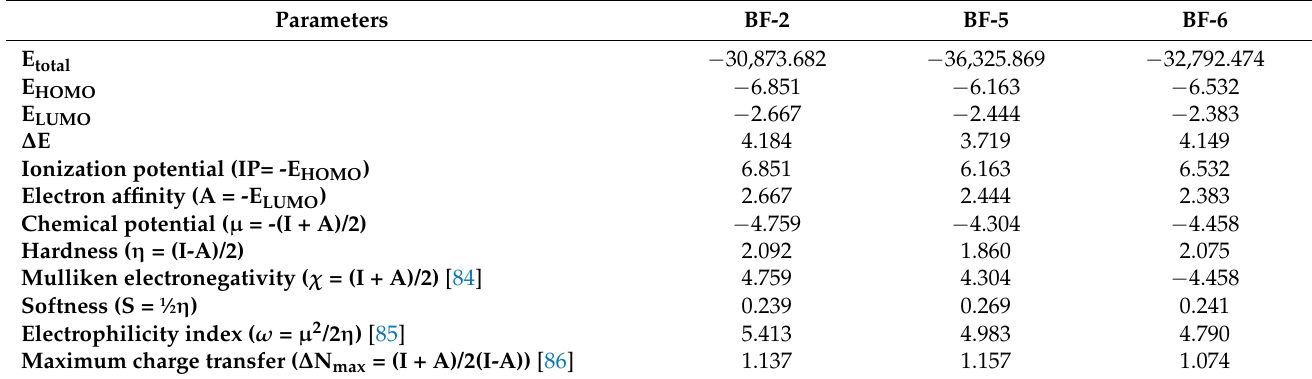
Table 9. The computed energy values and the related parameters for compounds BF-2, BF-5 and BF-6 (in